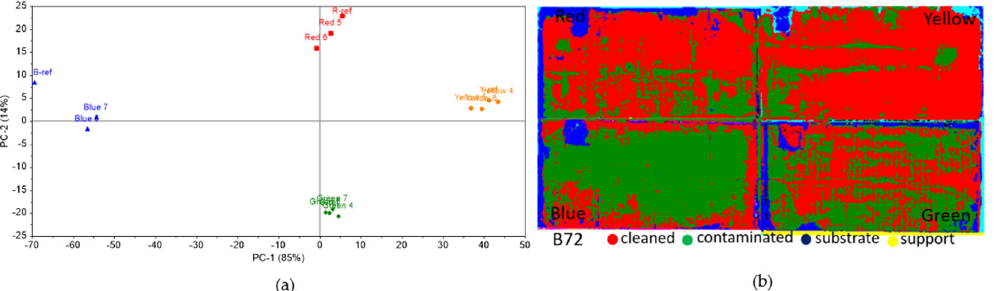
Figure 8. Colorimetric and hyperspectral evaluation of Paraloid B72 decomposition by fungal lipase. ( a ) Score plot of the first 2 PCs, based on colorimetry data; ( b ) SAM images based on hyperspectral data.